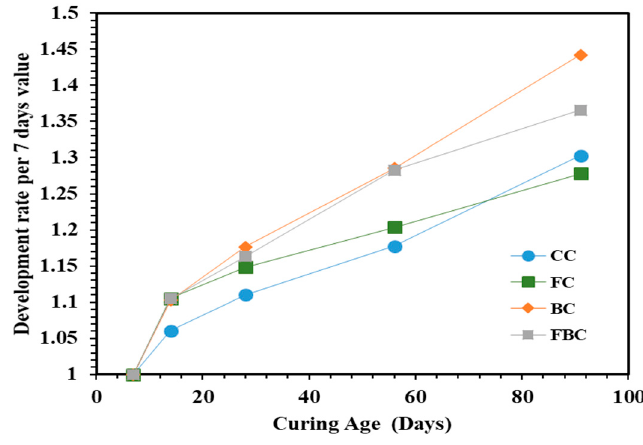
Figure 6. Development rate of UPV values for concrete cylinders containing FA and BT.